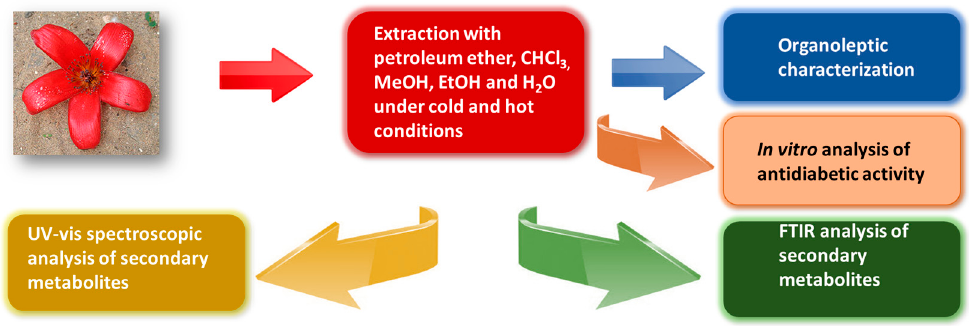
Figure 1. Schematic presentation of the present study.